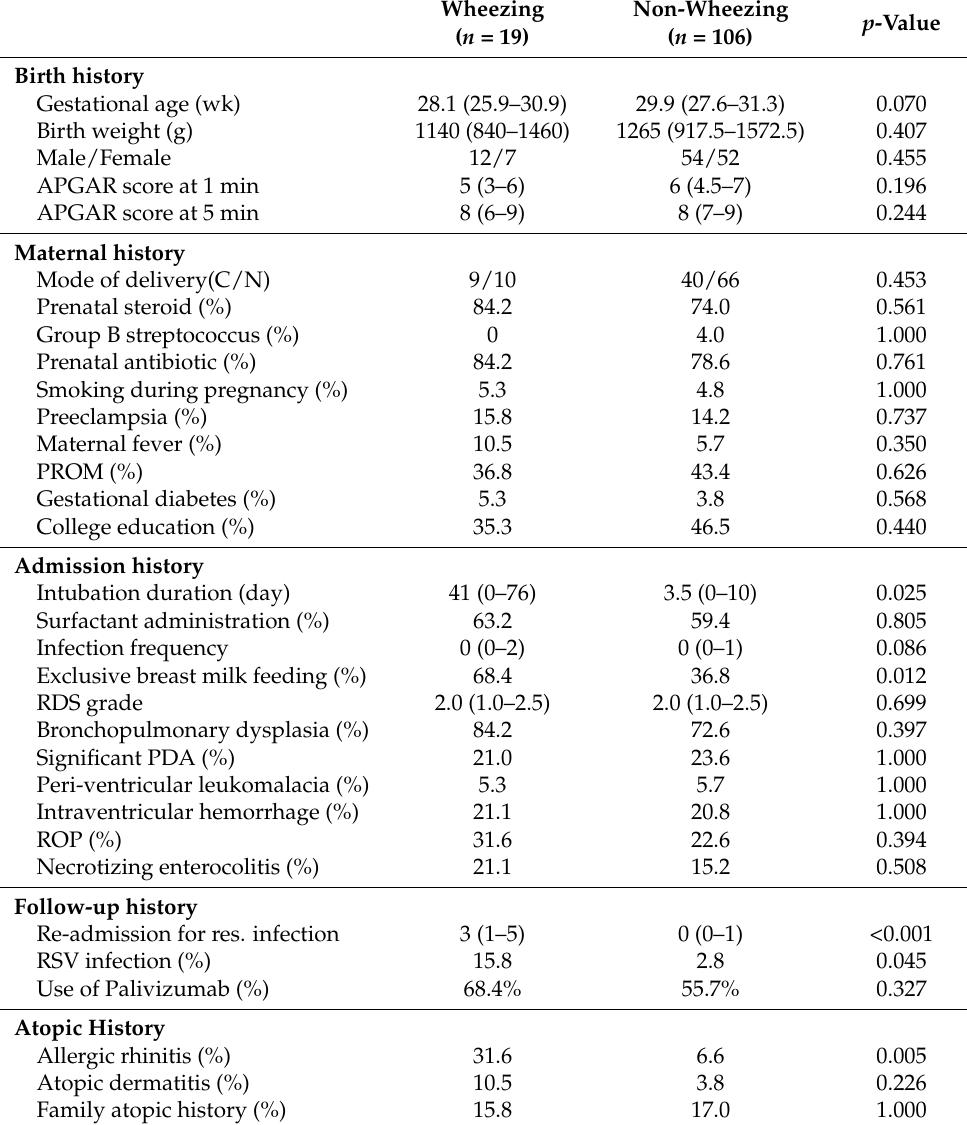
Table 1. Baseline characteristics between wheezing and non-wheezing